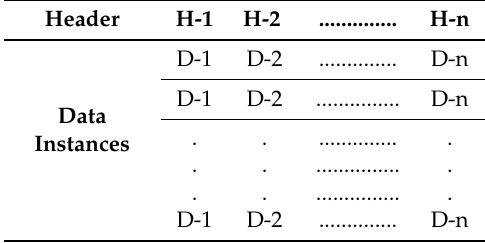
Table A2. Input Data Format for implemented RANs Modeling.